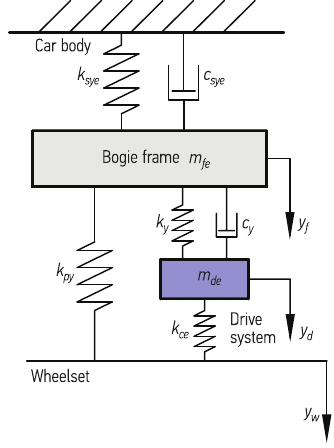
Fig. 9. The effect of f y on the ratio of track shift forces and phase difference Fig. 10. The lateral simplified model of the railway